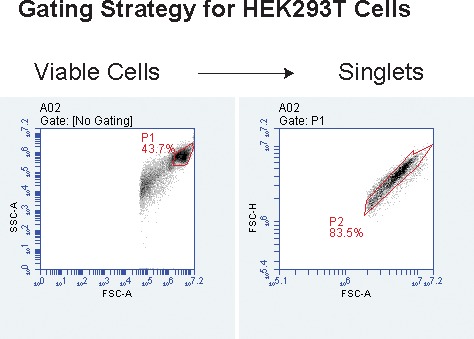
Representative gating strategy for CD81 null 293 T cells used in the CD19 export assay and CD19-CD81 fusion protein validation experiments.Cells were first gated on live cells and then on singlet cells.